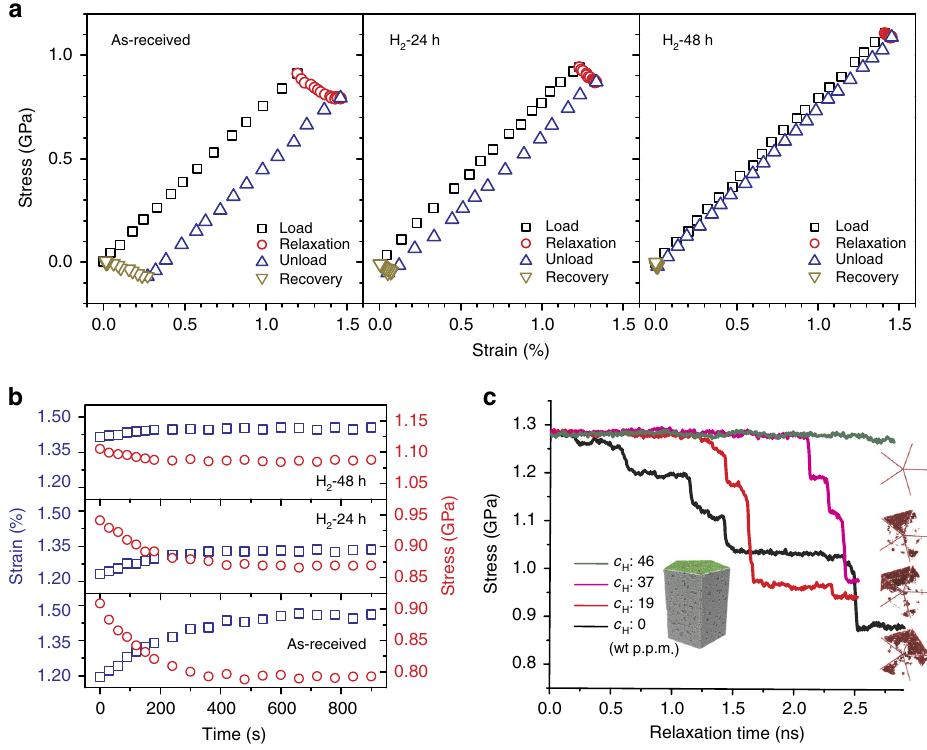
Fig. 3 In-situ TEM tests and MD simulations of stress relaxation. a Stress – strain curves from stress relaxation tests for penta-twinned Ag NWs at different concentrations of hydrogen. b Experimentally measured stress relaxation and associated strain evolution curves for penta-twinned Ag NWs at different hydrogen concentrations. c MD simulations of stress relaxation in penta-twinned Ag NWs at different hydrogen concentrations c H . Red atoms in the grain show stacking faults in the right